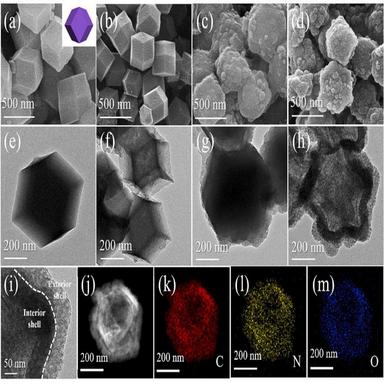
SEM images of the ZIF-8 (a), SEM images of the MNC-900 (b), SEM images of the ZIF-8@F127/TMB/mPDA composite (c), SEM images of the DHNCNs-900 (d). TEM image of the ZIF-8 (e), TEM image of the MNC-900 (f), TEM image of the ZIF-8@F127/TMB/mPDA composite (g), TEM images of the DHNCNs-900 (h), and HRTEM image of the DHNCNs-900 (i). Annular dark-field TEM image of the DHNCNs-900 (j) and the corresponding elemental mappings of carbon (k), nitrogen (l), and oxygen (m).